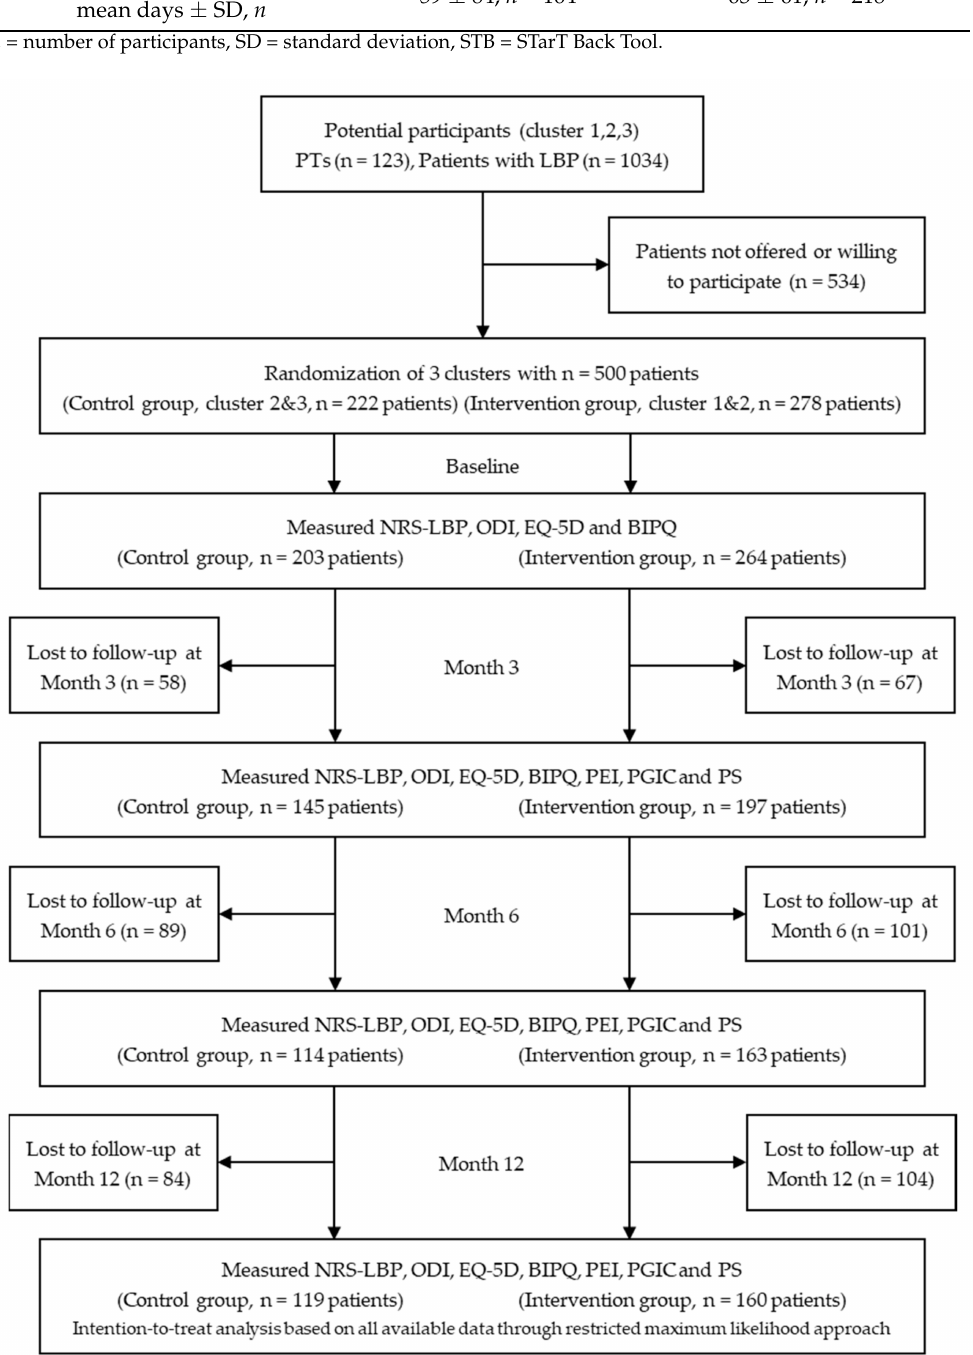
Figure 1. Flow diagram of participants throughout the trial. NRS-LBP = Numeric Rating Scale-Low Back Pain, ODI = Oswestry Disability Index, EQ-5D = EuroQol 5 dimensions, BIPQ = Brief Illness Perception Questionnaire, PEI = Patient Enablement Instrument, PGIC = Patient Global Impression of Change, PS = Patient